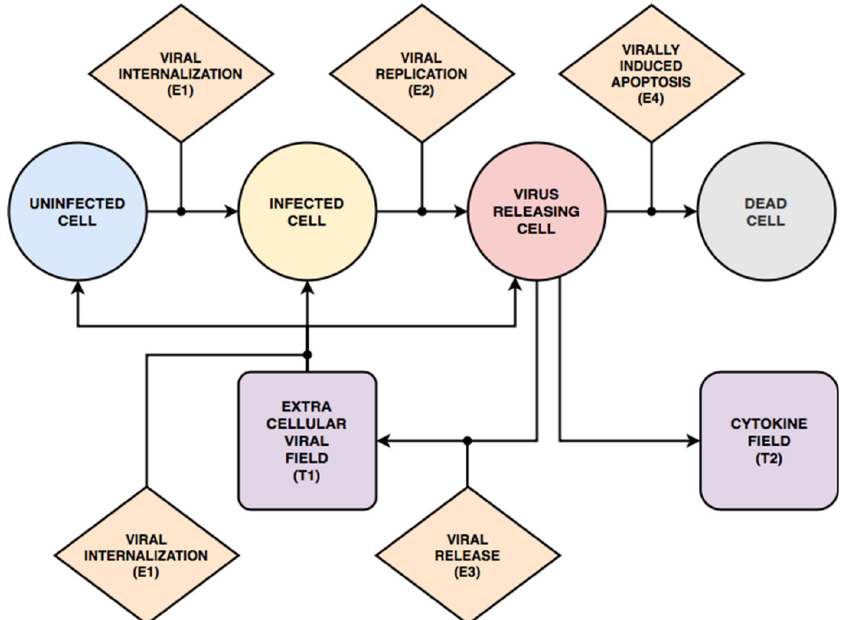
Fig 15. State diagram and interactions of epithelial cells.Epithelial cells can have one of four “cell types”: uninfected, infected, virus-releasing and dead. Uninfected cells become infected cells when the viral uptake model ( E1 ) internalizes viruses from the extracellular virus field ( T1 ). Infected cells continue internalizing viruses from the extracellular virus field and become virus-releasing cells when the viral replication model ( E2 ) produces sufficient newly assembled virions. Virus-releasing cells secrete viruses into the extracellular virus field ( T1 ) according to the viral release module ( E3 ) and secrete cytokines directly into the extracellular cytokine field ( T2 ). Virus-releasing cells can die if the conditions of the virally induced cell-death model ( E4 ) are